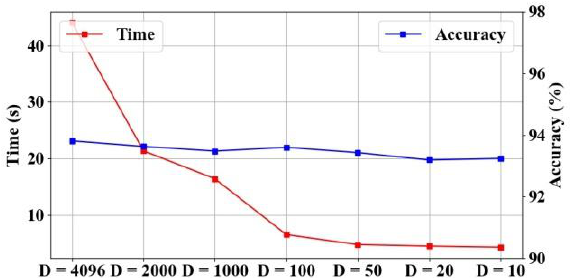
Figure 15. Influence of different feature dimensions, D . The left and right vertical coordinates represent the time consumption for solving Equation (3) and the classification accuracy, respectively.